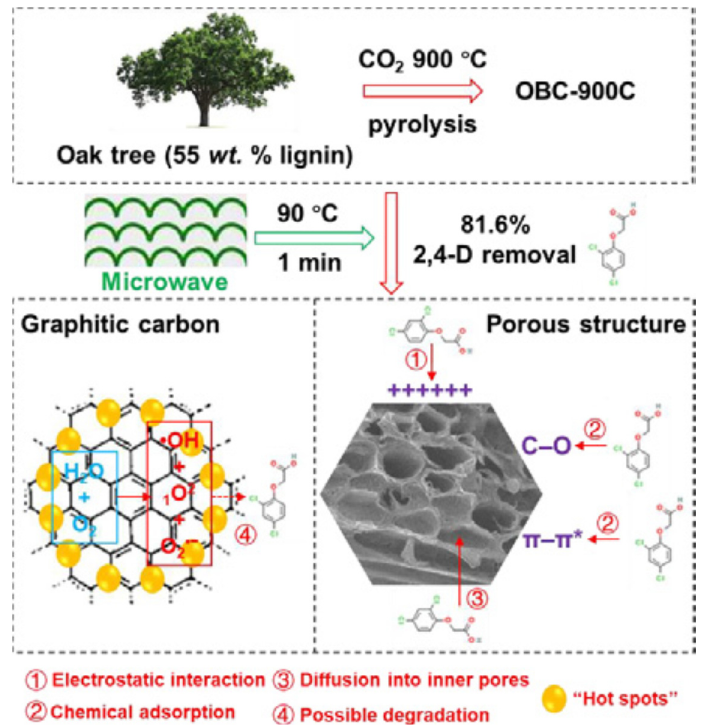
Figure 2. Schematic and images showing the conversion of oak tree wood waste to activated carbon via pyrolysis at 900 °C in CO 2 , adsorption of 2,4-dichlorophenoxy acetic acid (2,4-D) by the activated carbon under microwave irradiation, and the development of the microporous structure in graphitized carbon. Reproduced with permission from [12], ©2020 Elsevier B.V.